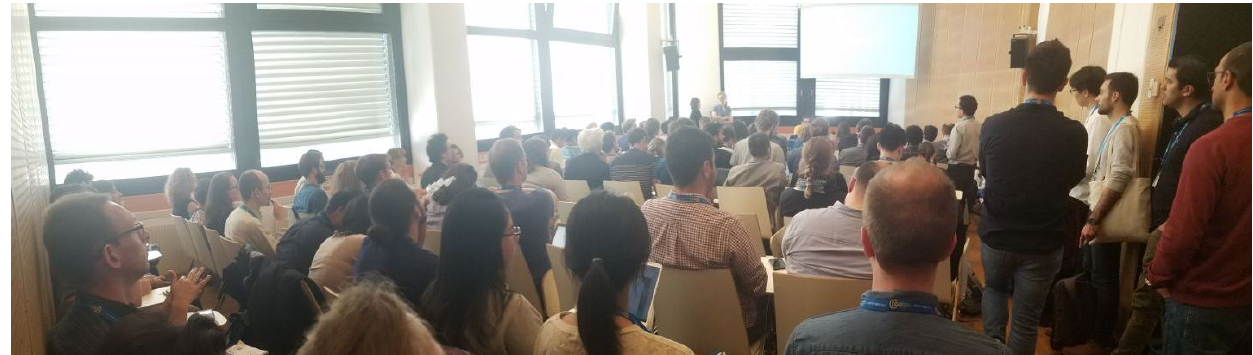
Figure 2. The EGU short course Using R in Hydrology, 11 April 2018.